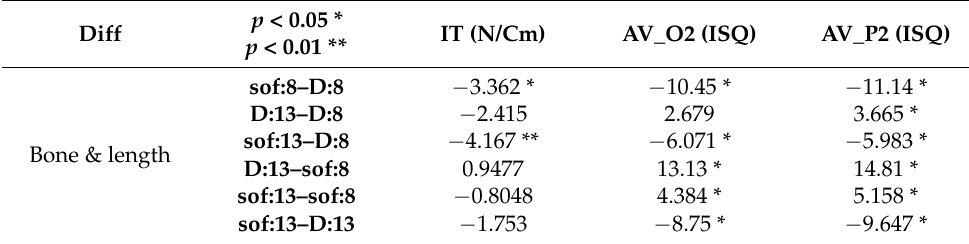
Table 3. The difference of average implant stability measurements between the combined tested parameters of bone type and implant length as measured by the IT, Osstell (O2), and Penguin (P2)